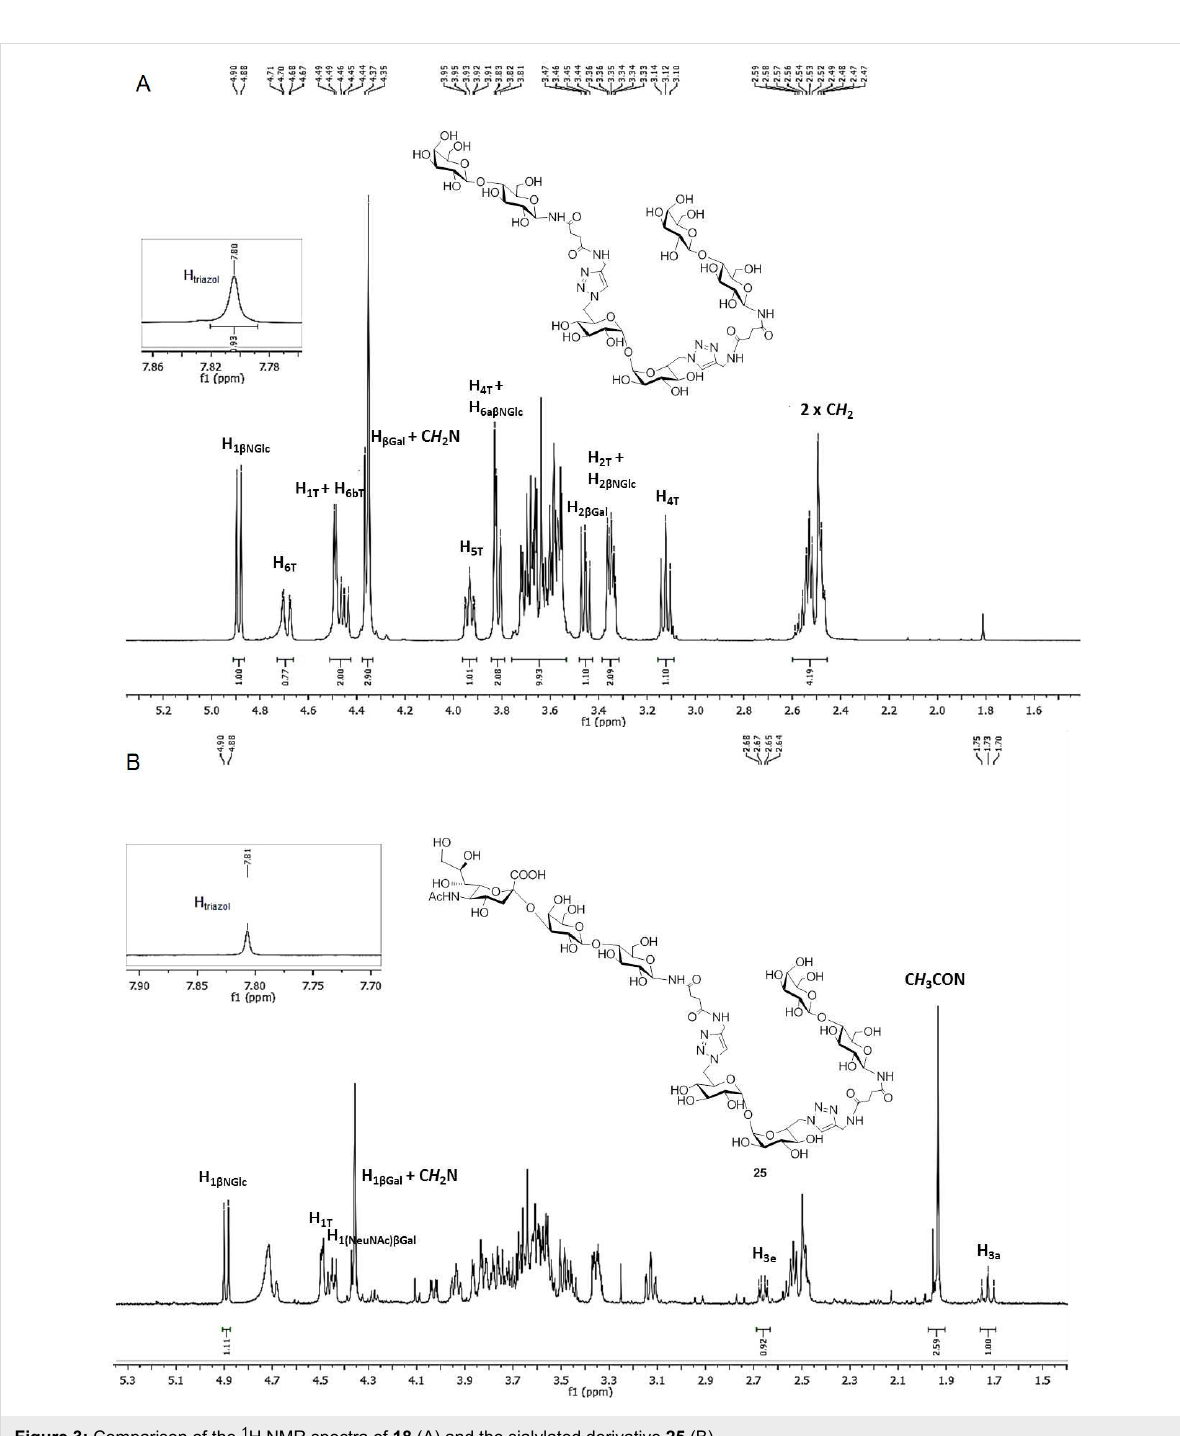
Figure 3: Comparison of the 1 H NMR spectra of 18 (A) and the sialylated derivative 25